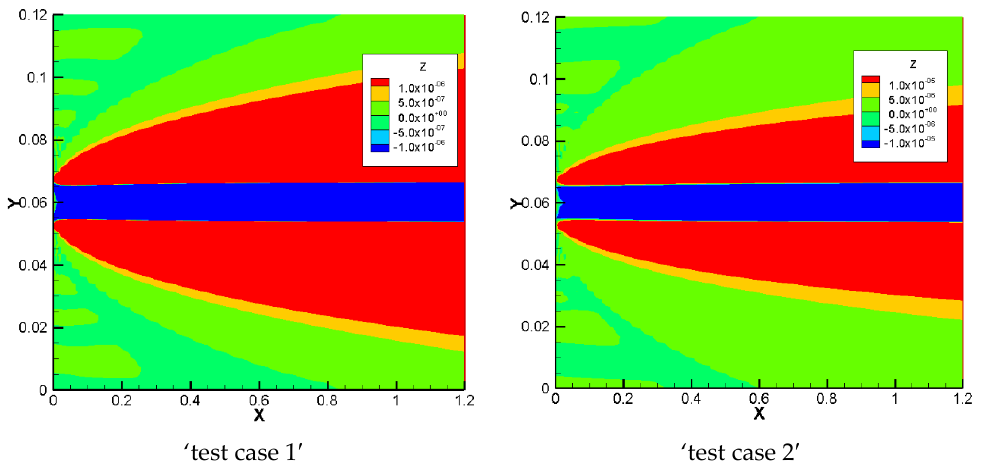
Figure 9. The total charge for the 2D benchmark with the NC-model: low sorptivity (test case 1), high sorptivity (test case 2).